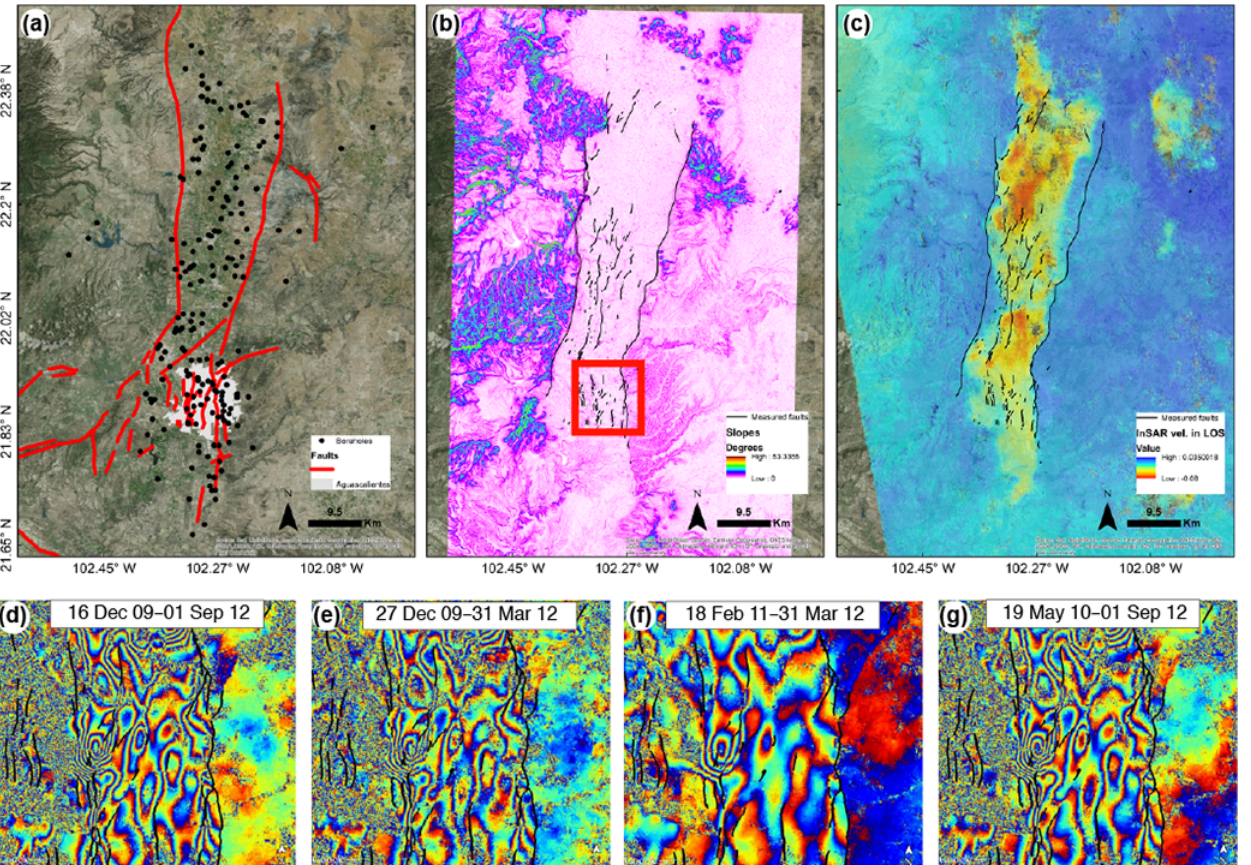
Figure 2. Case example of differential subsidence analysis over Aguascalientes Valley. (a) Satellite image (source: © Esri, Digital Globe, GeoEye, Earthstar Geographics, CNES Airbus, USDA, USGS, ADX, Getmapping, Aerogrid, IGN, swisstopo, and the GIS community) overlaid by locations of groundwater-extraction wells in the area. Red lines represent faults mapped in the city. (b) Slopes map from SRTM topographic data. Red square shows the limits of (d) – (g) . (c) Velocity map from 34 ALOS PALSAR scenes acquired form August 2007 to March 2011. (d) – (g) High resolution interferograms of Aguascalientes’ urban area from TerraSAR-X data. Each fringe corresponds to 1.55cm of